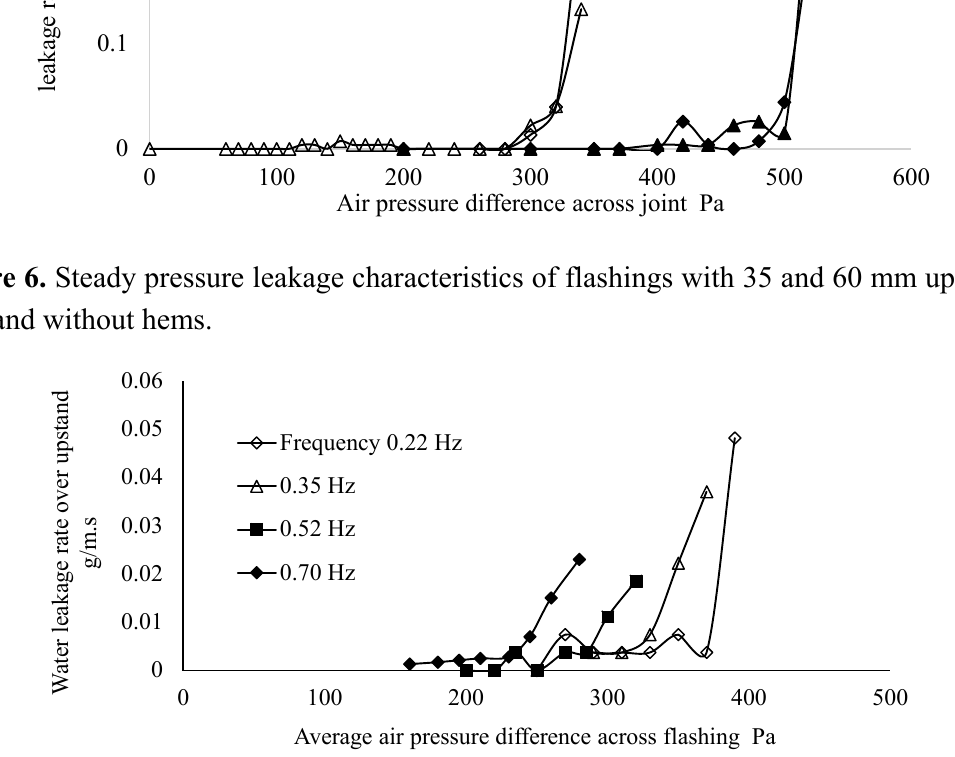
Figure 7. Dynamic leakage characteristics of flashings with a 35 mm upstand and a